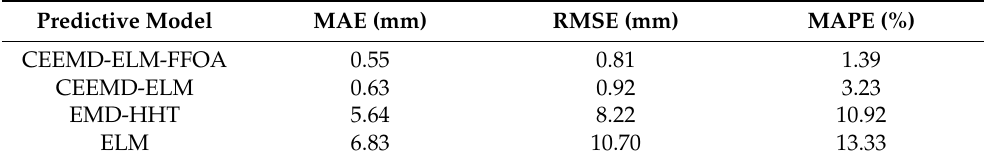
Figure 11. Taylor diagrams for statistical comparison of di ff erent models. As shown in Table 4 and Figures 9–11, the CEEMD-ELM-FFOA coupling model achieved the highest goodness of fi t for predicting precipitation, and its MAE, RMSE, and MAPE were lower than those of the other three prediction models; the goodness of fi t of the CEEMD-ELM prediction model was higher than that of the EMD-HHT prediction